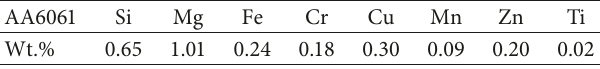
Table 1: Chemical composition of AA6061 alloy